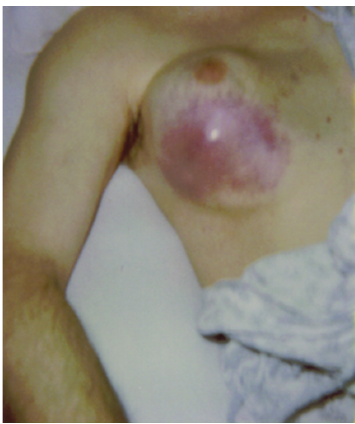
Figure 1: Right breast mass with overlying skin discoloration.